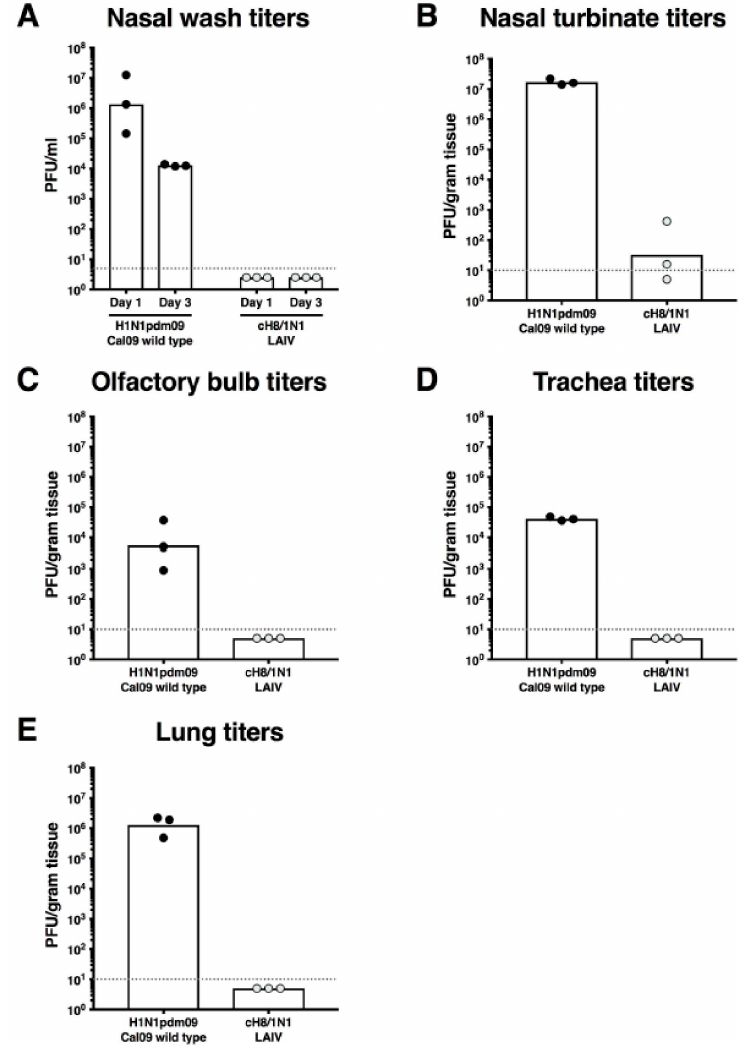
Figure 2. In vivo characterization of the LAIV virus. The level of replication of the cH8/1N1 LAIV (light gray circles) virus was compared to the replication of a wild type pandemic H1N1 virus (black circles) in three ferrets. Viral titers were measured in nasal wash titers ( A ) on days 1 and 3 post-infection. After euthanizing the ferrets on day 4 post-infection, viral titers were measured in the nasal turbinates ( B ), olfactory bulbs ( C ), tracheas ( D ), and lungs ( E